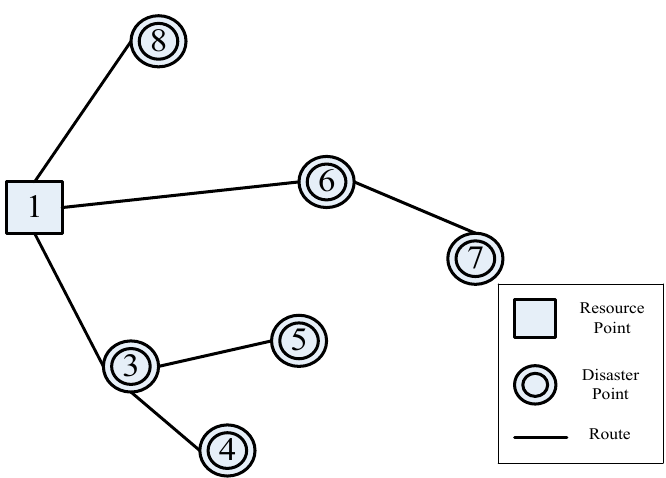
Figure 4. Diagram of initial stage of the disaster (Case 2). Table 6. Resources required for the initial stage of a disaster and repair durations (Case 2). Disaster Point No.